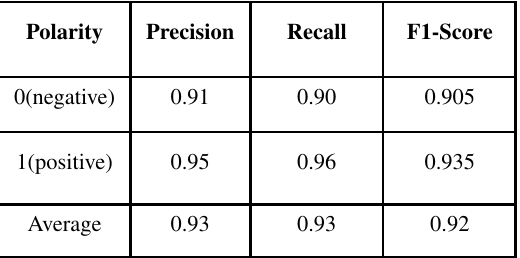
Fig. 8. Proposed Model Confusion Matrix Table 3. Classification Report of proposed